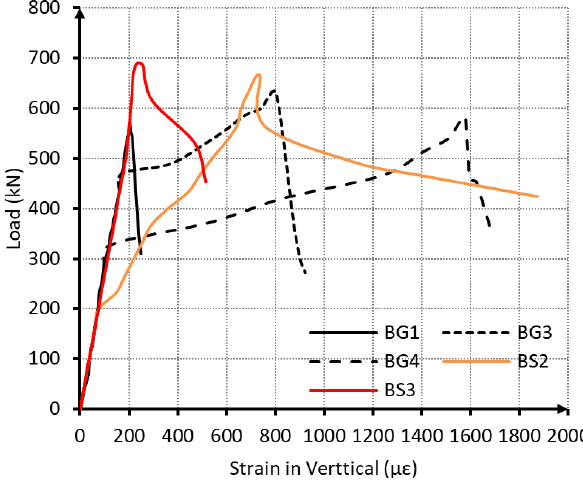
Figure 19: Strain curve of vertical web reinforcement for deep beams